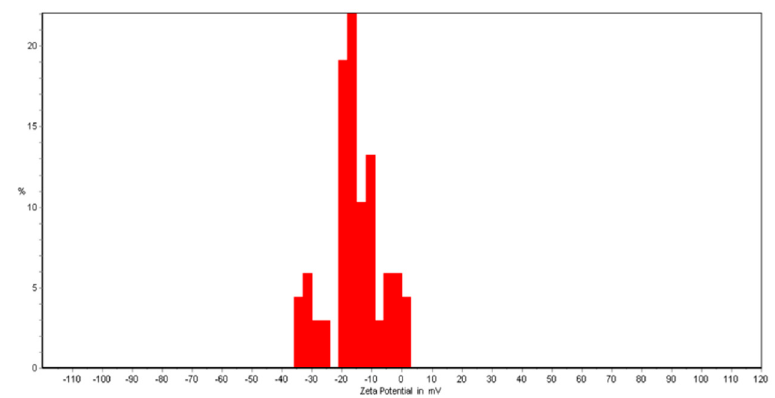
Figure 1. Zeta potential of Mg 0.99 Zn 0.01 O nanoparticle at a pH of